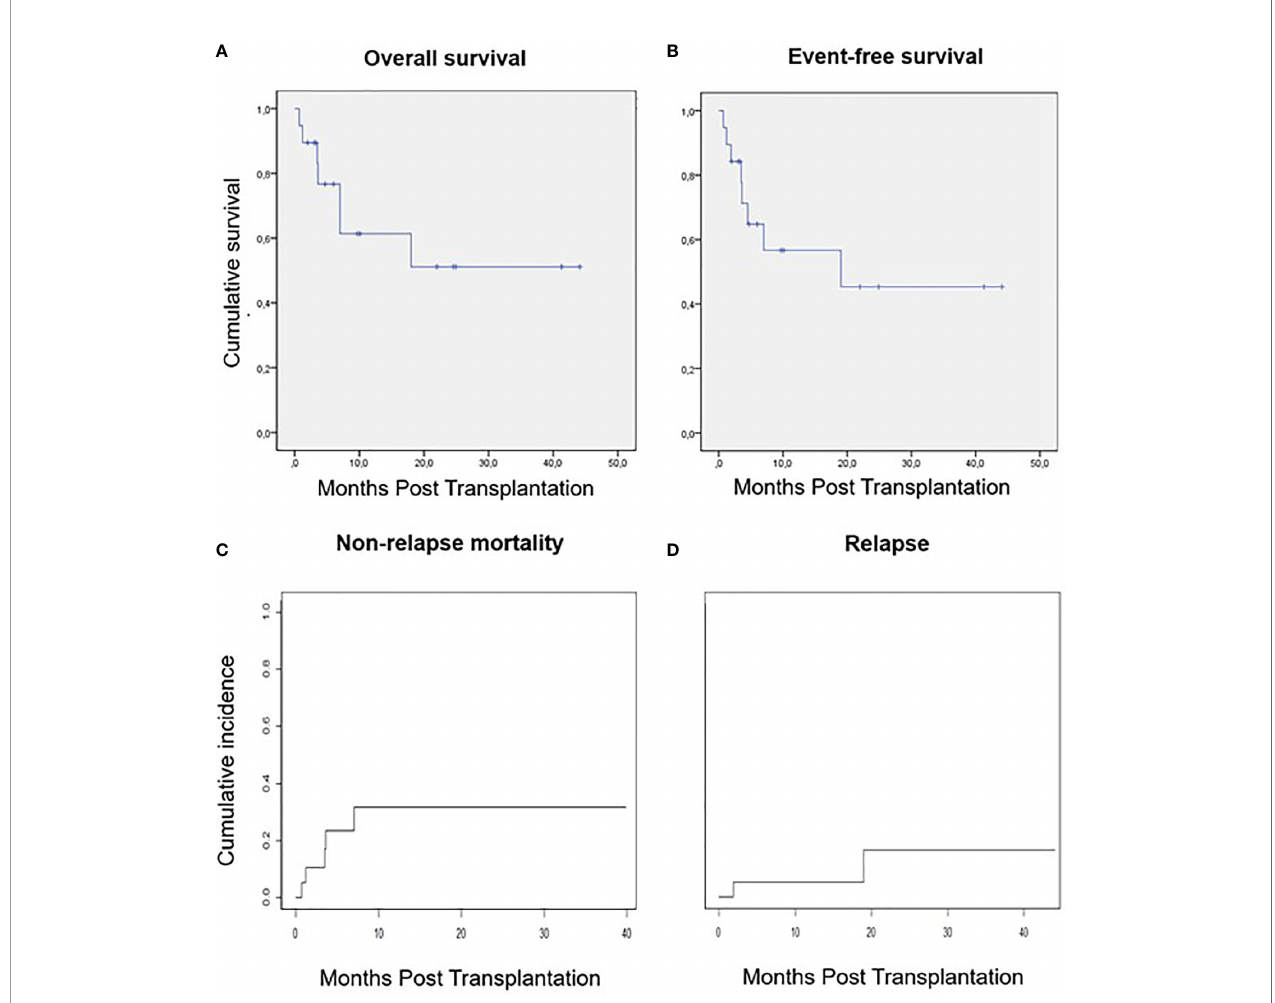
FIGURE 2 | Survival, relapse and non-relapse mortality. (A) Overall survival. (B) Event-free survival. (C) Non-relapse mortality. (D)